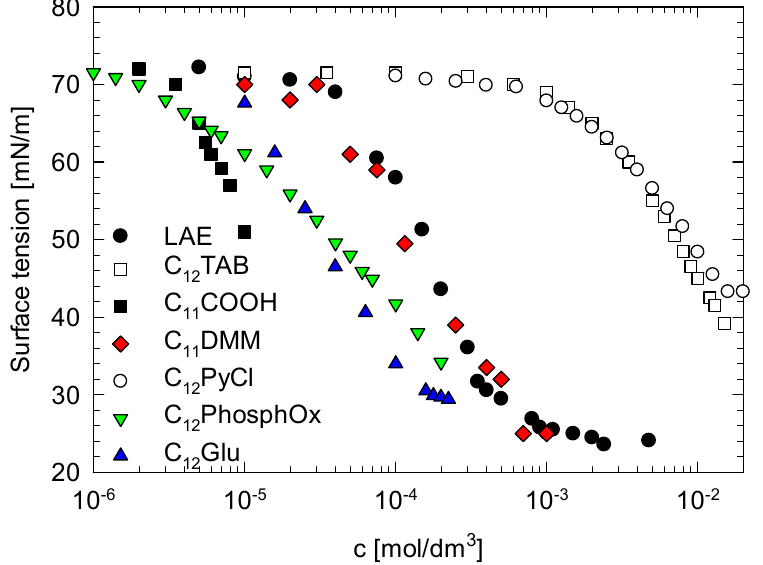
Figure 1. The comparison of the surface tension isotherm of LAE with ones obtained for some model cationic and nonionic surfactants: dodecyl trimethylammonium bromide (C 12 TAB), dodecyl pyridinium chloride (C 12 PyCl), (C 11 COOH), n -dodecyl- β - D -glucoside (C 12 Glu), n -dodecyl dimethyl phosphine oxide (C 12 PhospOx) and N , N , N -trimethyl-2-(dodecanoyloxy)ethane ammonium bro- mide (C 11 DMM).